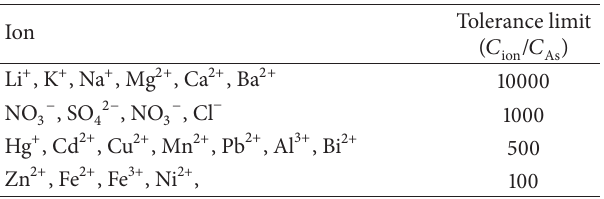
Table 3: Effect of diverse ions on the preconcentration of As (5 𝜇 g/L As).